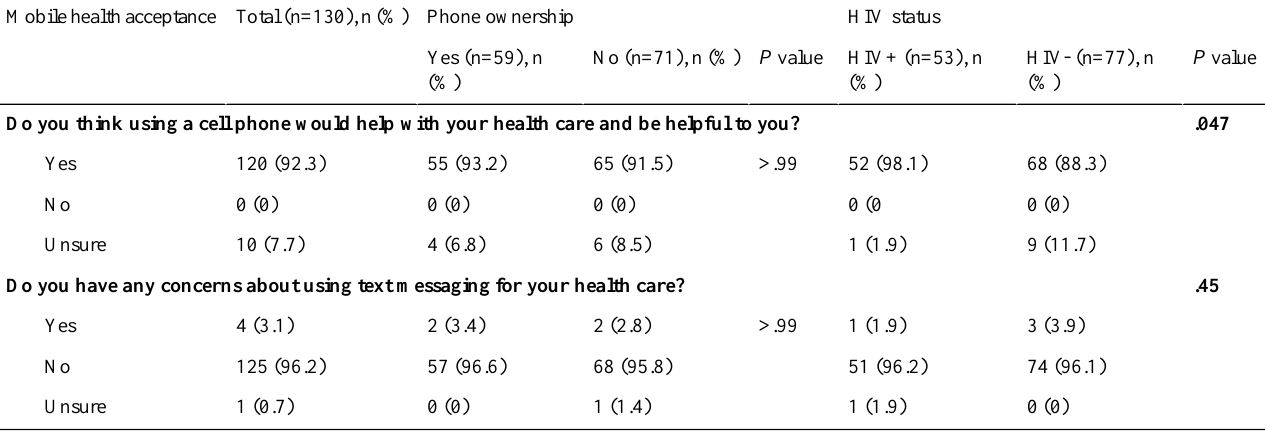
Table 3. Self-reported mHealth acceptance stratified by phone ownership and HIV status (N=130).